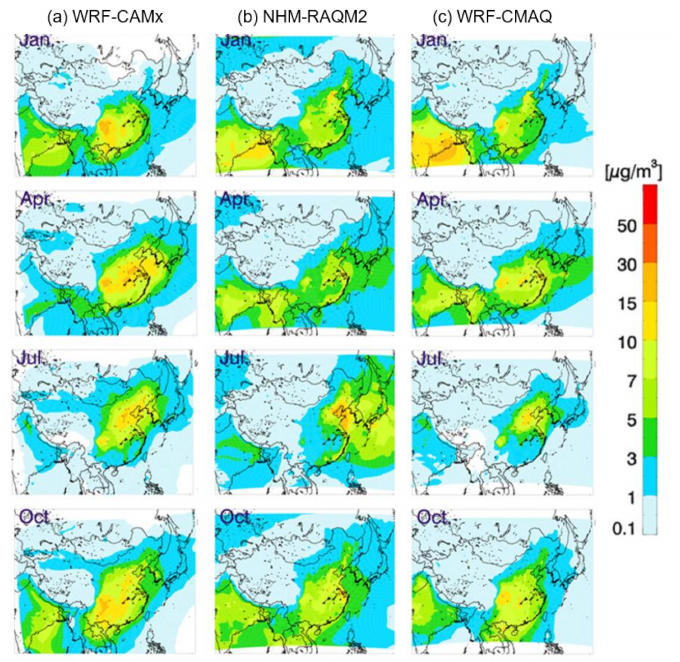
Figure 3. As in Figure 2, but for SO 42 − concentrations ( µ g/m 3 ). NO 3 − inorganic component: Figure 4 shows the spatial distributions of NO 3 − concen- trations. The results for NO 3 − indicated higher inter-model biases than SO 42 − , the causes of which were less clear than those of the SO 42 − component, but these were likely due to uncertainties in either emission estimates or inherent SIA module limitations. Among the three models, WRF-CAMx produced the most severe underestimation, except during winter. NHM-RAQM2 simulated small seasonal variations, with consistent peaks in some areas and nearly uniform maximum NO 3 − levels greater than 20 µ g/m 3 in all seasons.